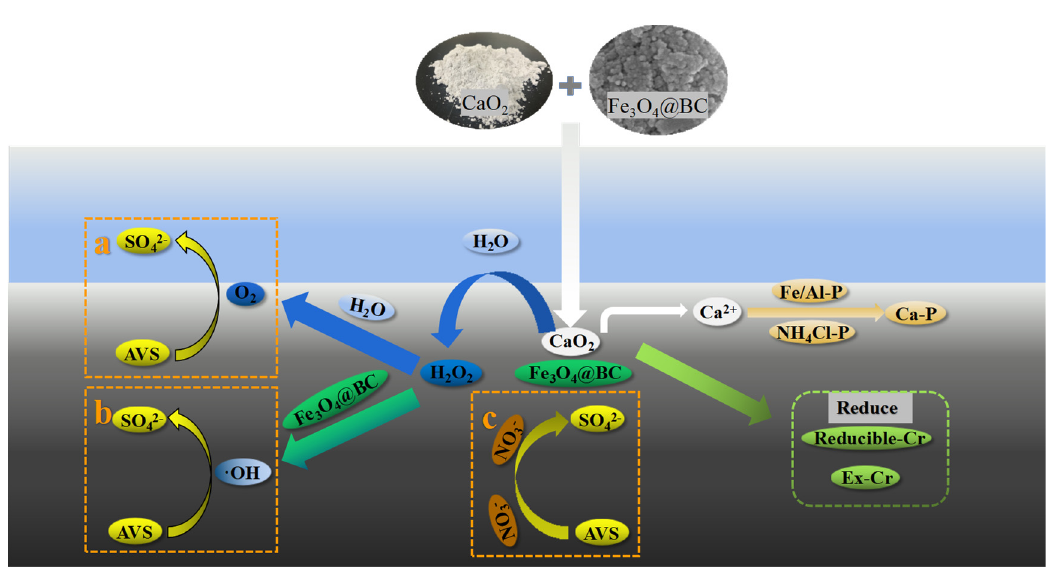
Figure 9. Synergistic reaction mechanism of Fe 3 O 4 @BC and CaO 2 ; ( a ) Oxygen oxidizes AVS. ( b ) Hydroxyl radical oxidizes AVS. ( c ) Autotrophic sulfide drives denitrification.